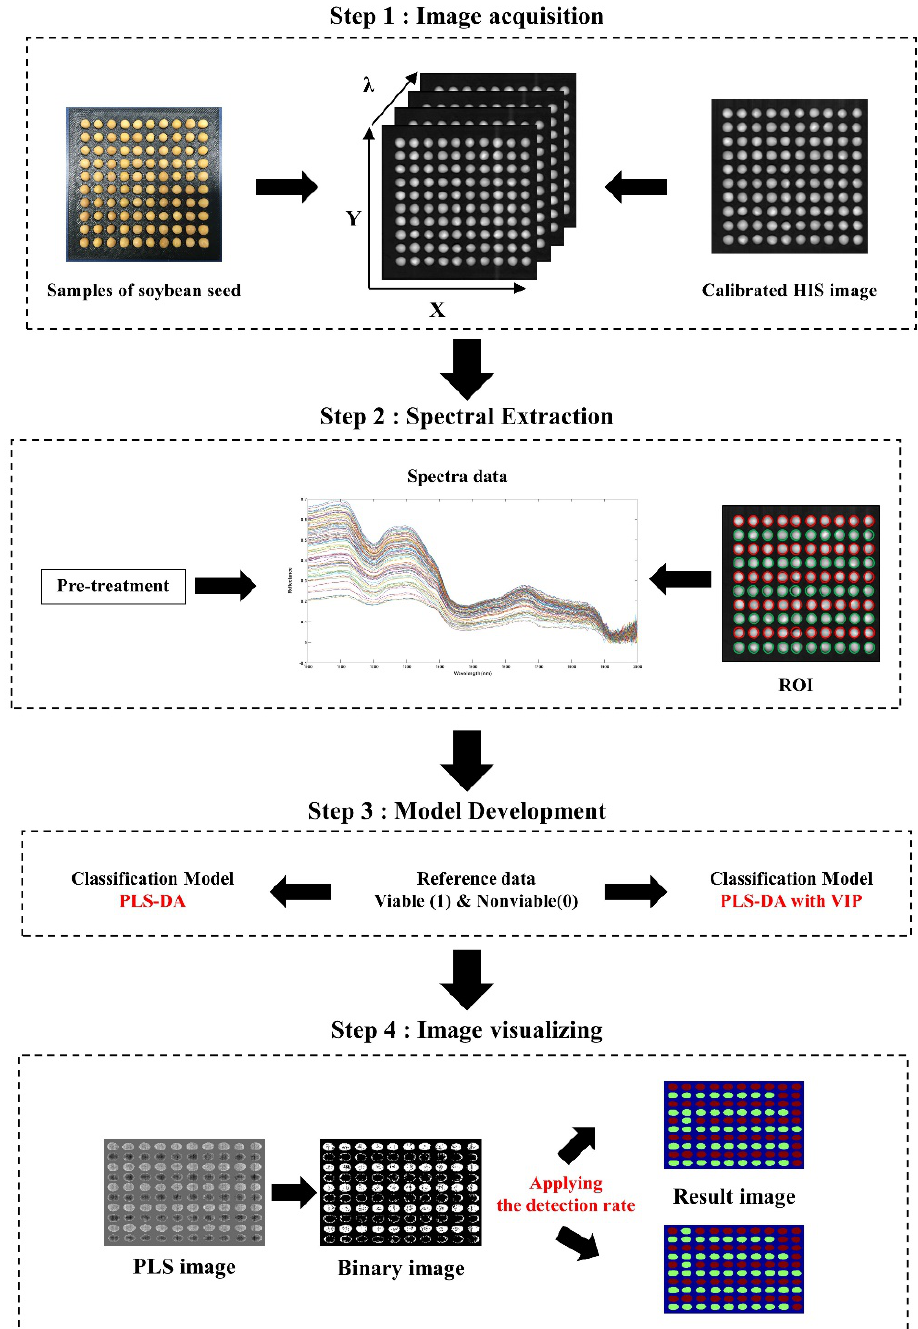
Figure 3. HSI data processing workflow used for viability determination of soybean seed samples.